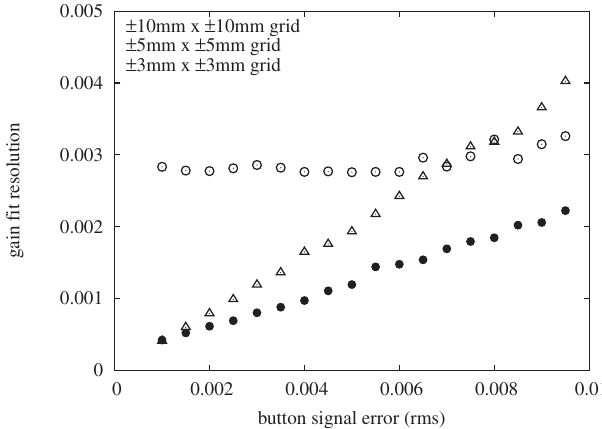
FIG. 8. Simulation of the resolution of the fitted gain as a function of the BPM button measurement resolution (button signal error) for three different size grids. The (cid:8) 5 mm square grid is characteristic of resonantly excited turn-by-turn data. The model is good to second order in grid size. Third order effects are evident in the limited resolution of the fits to the data in the (cid:8) 10 mm square grid.